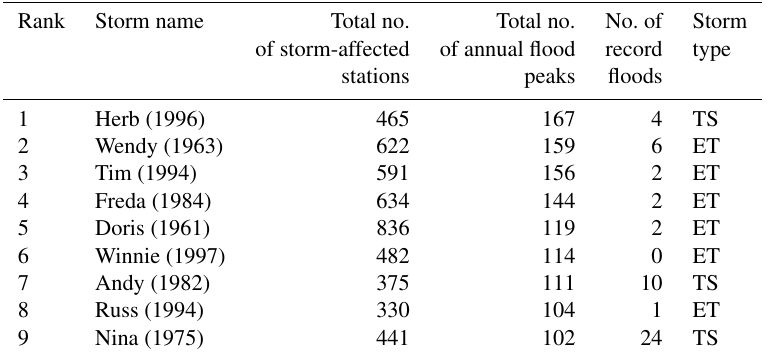
Table 1. Summary of tropical cyclones that produced more than 100 annual flood peaks over China. All the stations that are located within the 500km buffer zone of each tropical-cyclone track are counted. The “storm type” column shows whether the tropical cyclone experienced an extratropical transition (ET) or not (TS). Rank Total no. Total